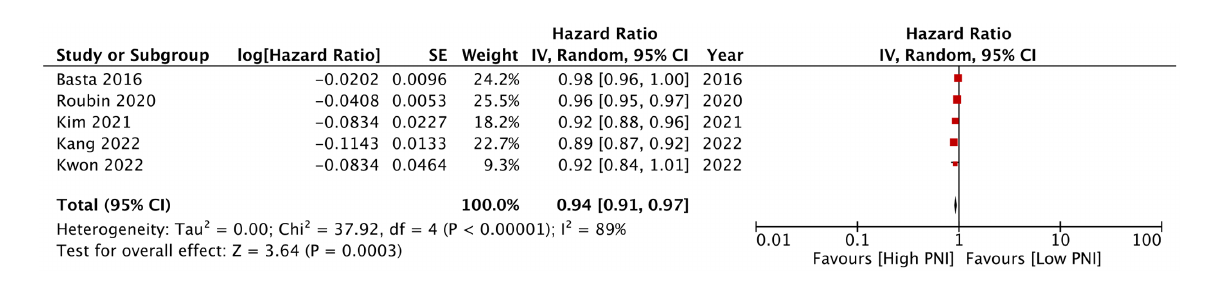
FIGURE 6 Meta-analysis of mortality with PNI as a continuous variable.